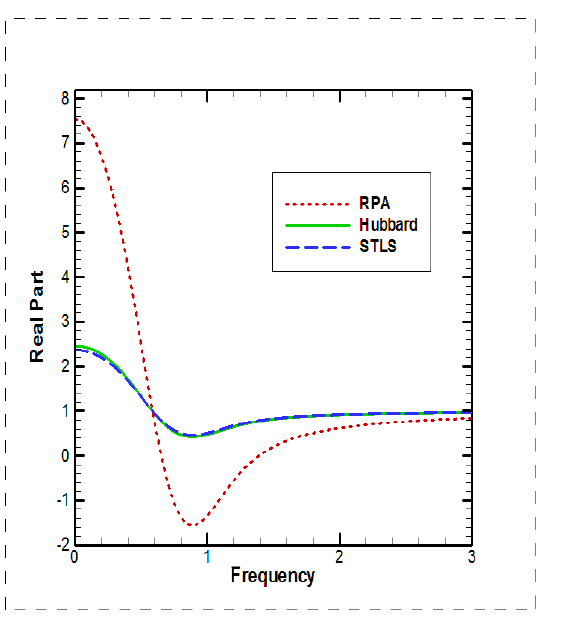
Fig. 1. Imaginary Part of dynamic dielectric function of single nanolayer within all approximations.